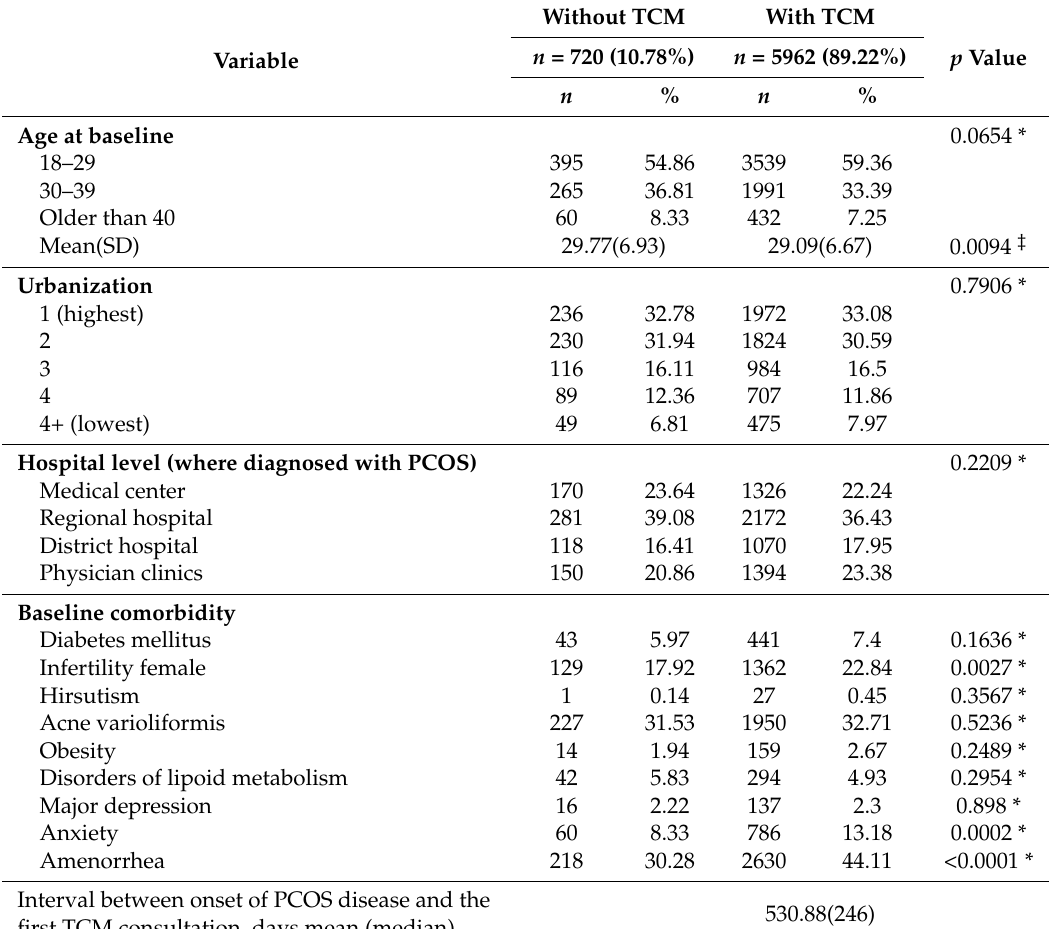
Table 1. Demographic characteristics of the patients newly diagnosed with PCOS in Taiwan in